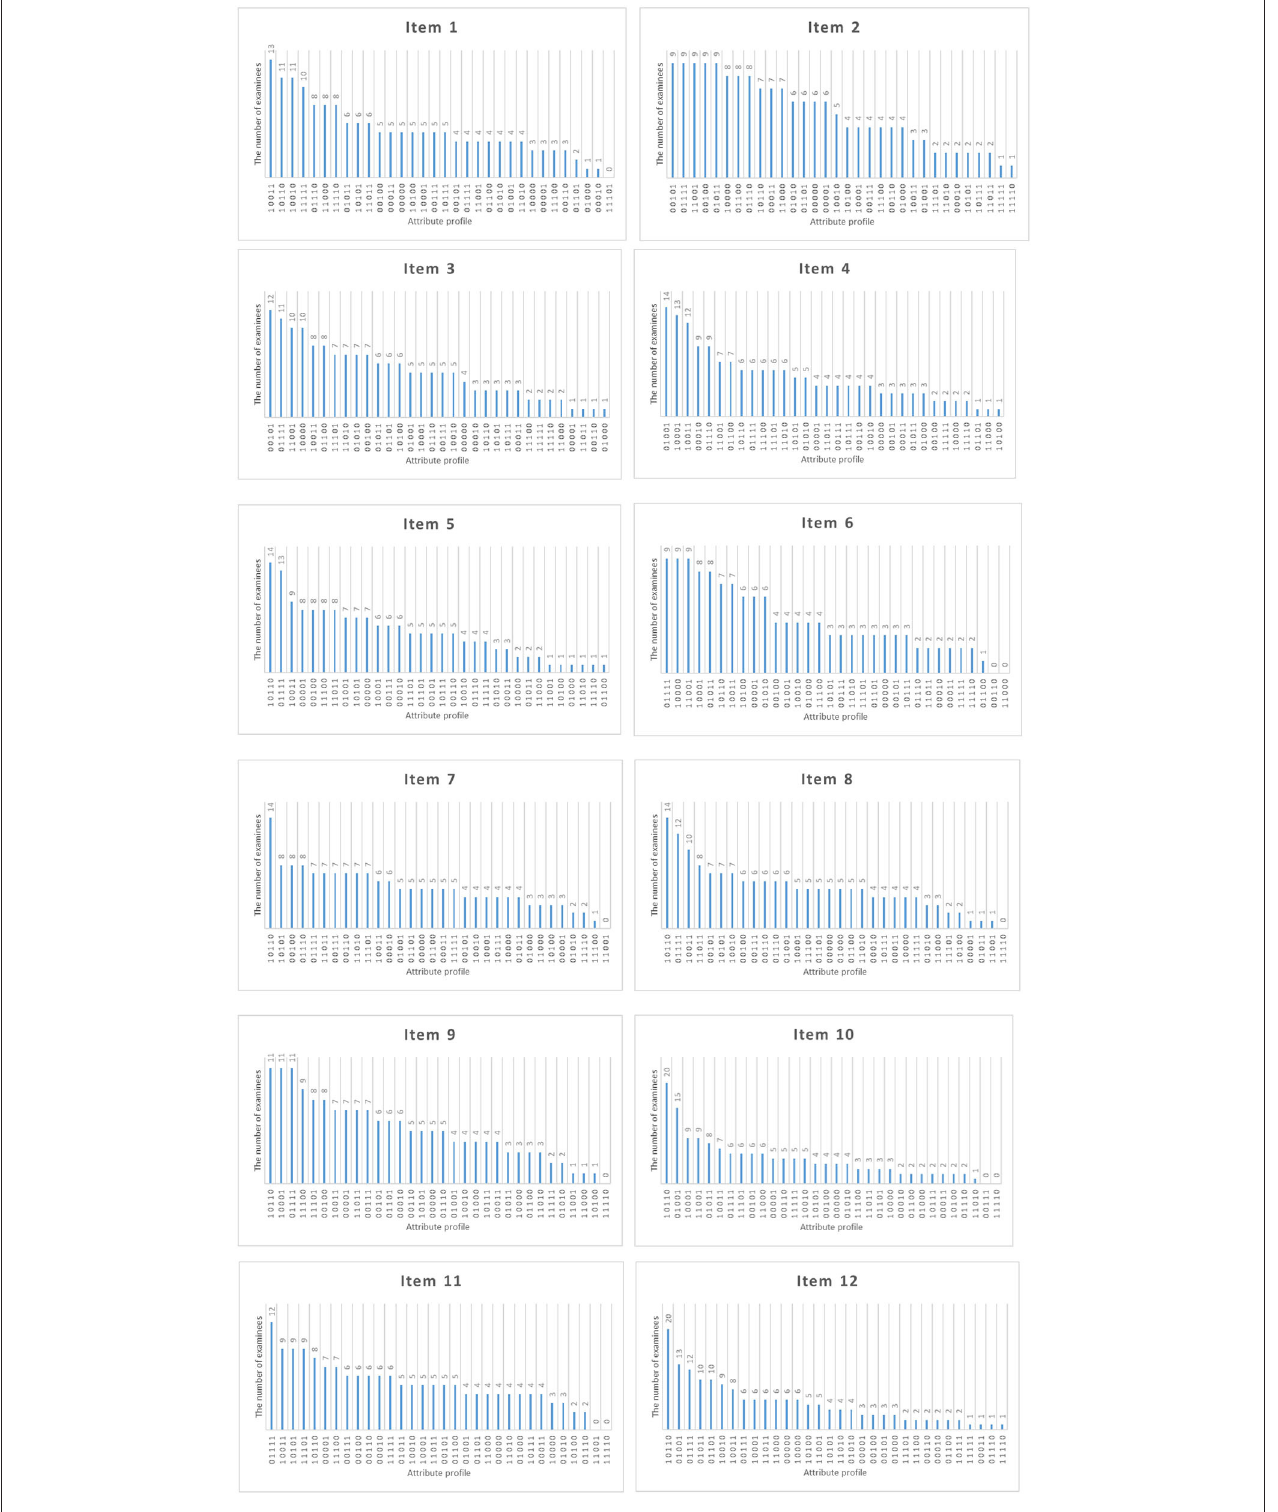
FIGURE 15 | The number of examinees in various attribute mastery pattern assigned to each item under D-optimal strategy.